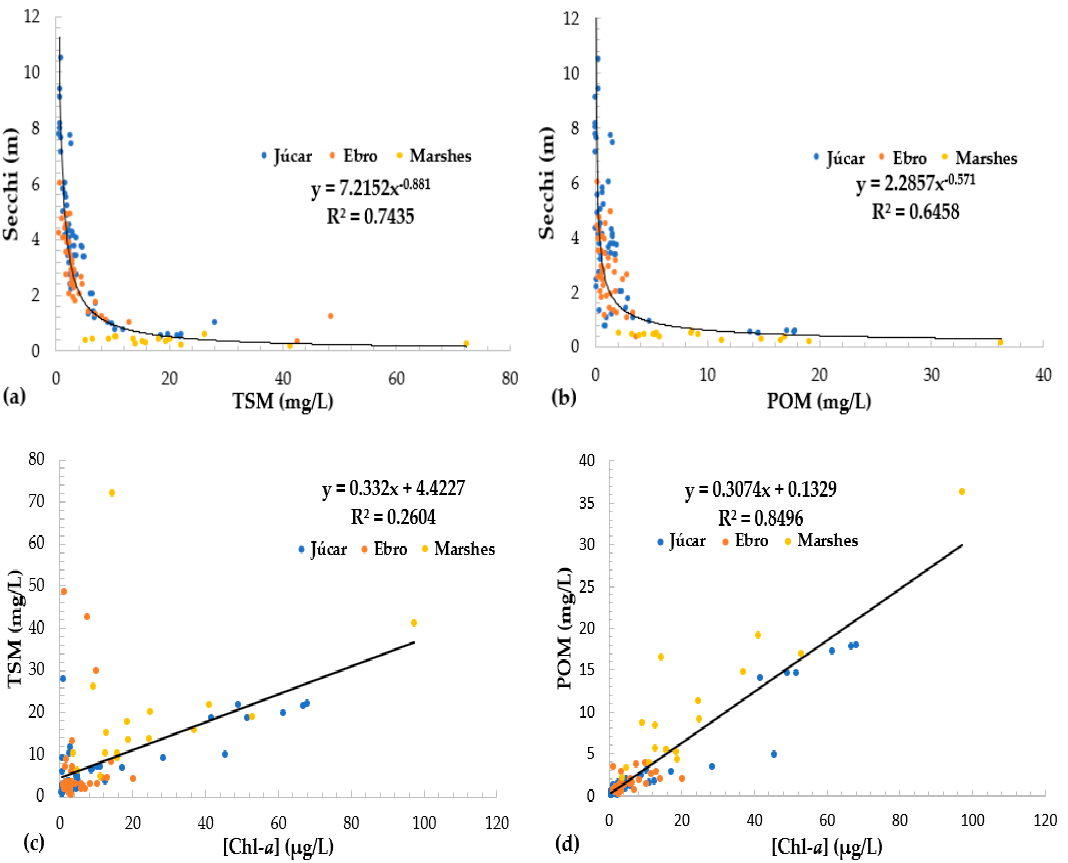
Figure 5. SDD as a function ( a ) Concentration of TSM and ( b ) Concentration of POM for the different in situ values. ( c ) Concentration of TSM and ( d ) Concentration of POM as a function of [Chl- a ] for the in situ values.